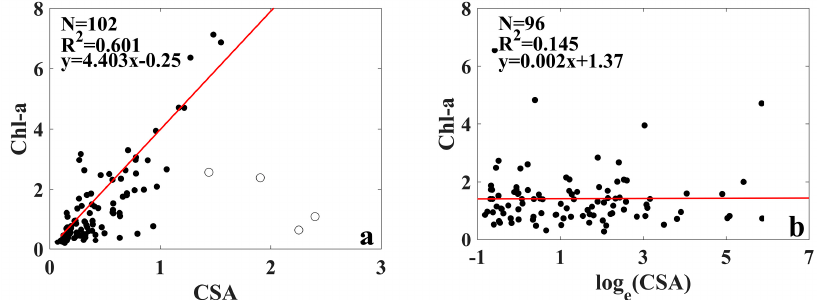
Figure 10. The relationship between CSA and chlorophyll-a concentration (Chl-a) for ( a ) summer; ( b ) winter; the red lines represent the fitting curve. The open circles represent sampling stations located near the coast.